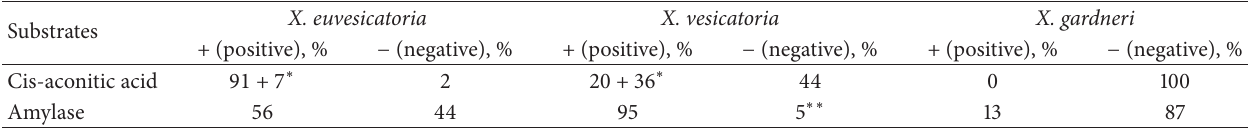
Table 1: Utilization of cis-aconitic acid and amylase activity by the Bulgarian strains of genus Xanthomonas isolated from pepper, tomato, and weeds. X. euvesicatoria X. vesicatoria X. gardneri Substrates